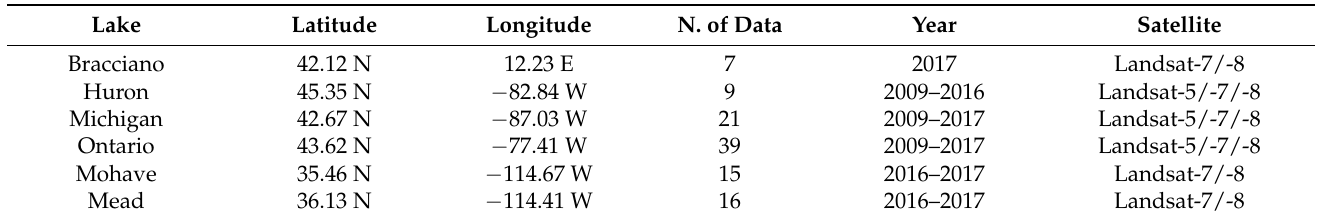
Table 9. Summary of the in situ data considered for validating the WST obtained with the proposed standard algorithm.